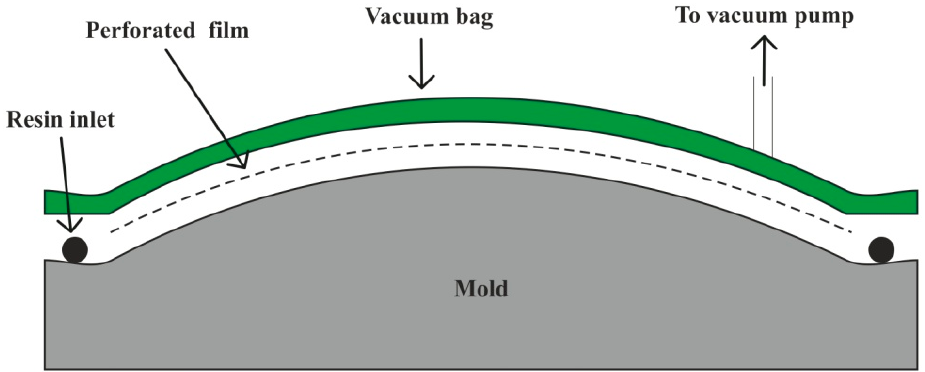
Figure 7. Vacuum infusion process.